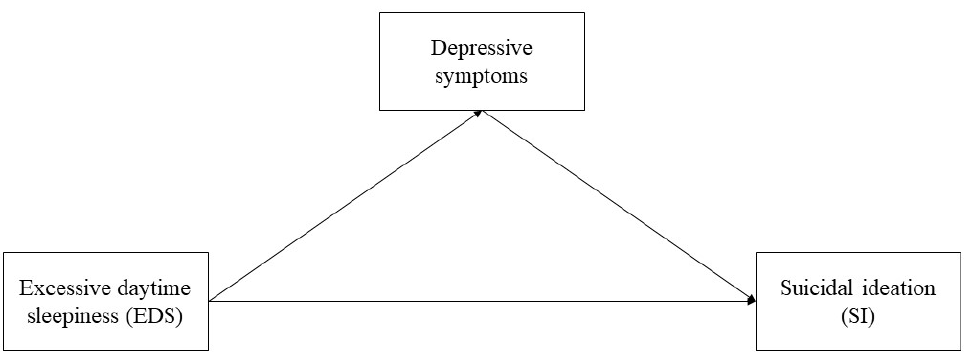
Figure 1. The mediating effect model of depressive symptoms on the relationship between excessive daytime sleepiness and suicidal ideation.